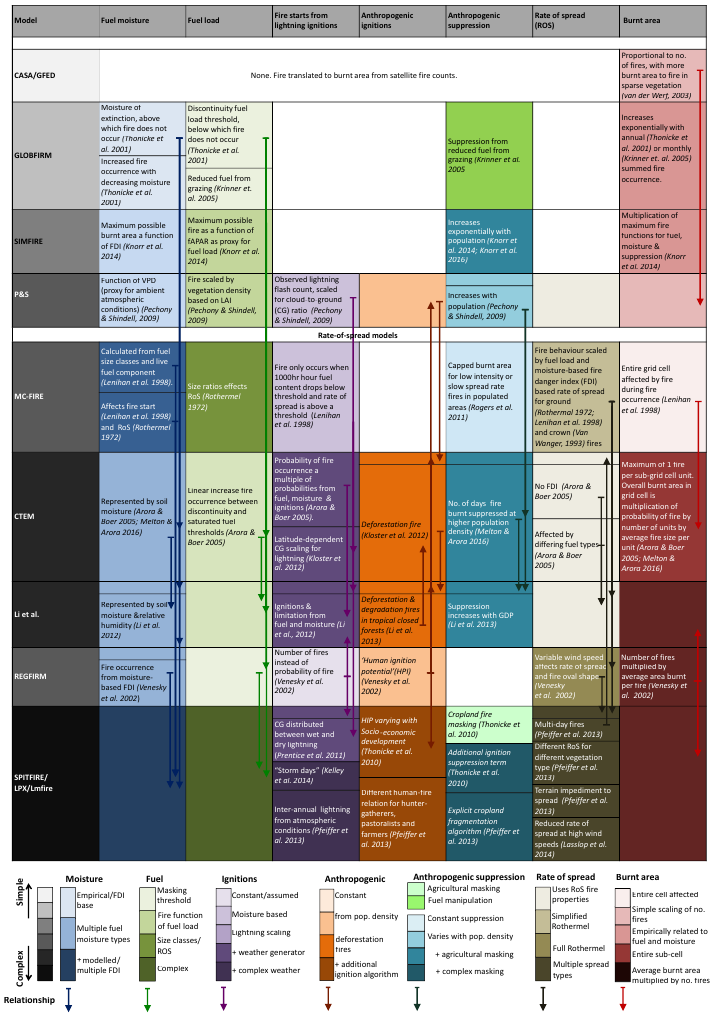
Table 1. Representation of fire processes in fire-enabled DGVMs. The intensity of the colour represents the complexity of the description of the process. Shades of grey describe the complexity of the model as a whole: light grey is the simplest and black the most complex. Blue represents the complexity of description of moisture control on fire susceptibility ranging from simple statistical relationships/fire danger indices (FDIs) of fuel as a whole (light blue) to description of moisture in multiple fuel size classes to fully modelled or specifically chosen FDIs for specific fuel moisture (dark blue). Green represents the complexity of fuel controlled fire susceptibility: simple masking at a specified fuel threshold (light green); fuel structure effects on ignition probability and rate of spread; and complex modelling of fuel bulk density (dark green). Purple shows complexity of natural ignition schemes: no specified/assumed ignitions (white); constant ignition source (light purple); simple relationship with fuel moisture; prescribed ignitions – normally through lightning climatology inputs; prescribed lightning with additional scaling for, for example, latitude-dependent cloud-to-ground lightning (CG); daily distributed lightning via a weather generator; and with additional complex ignition simulation (dark purple). Orange represents anthropogenic ignitions: none (white); constant background ignition source (light orange); ignitions varying based on human population density based on a “human ignition potential” (HIP) and/or gross domestic product (GDP); and inclusion of additional, complex human ignition schemes such as pre-historic human behaviour (dark orange). Cyan and lime green represent inclusion of human ignitions suppression and agriculture: none (white); constant suppression (light cyan); increasing suppression with population (medium cyan); simple agricultural masking of fire (light lime green); fuel load manipulation from agriculture (lime green); and a mix of agricultural and ignition suppression (dark cyan). Italic text under “human ignitions” and “human suppression” denotes models where the combined influence of human ignitions and suppression result in a unimodal description of fire relative to population density. Brown shows complexity of the calculation of fire sizes, typically through a rate-of-spread model (RoS): none (white); simplified RoS model to obtain fire properties (light brown); simplified RoS to model individual fires; full Rothermel RoS; and multiple RoS models (dark brown). Red shows complexity of the calculation of the overall burnt area: the entire cell is affected by fire (light red); constant scaling of the number of fires to burnt area depending on vegetation type; scaling based on moisture and fuel type; entirety of a sub-cell affected; and scaling of number of fires by fire size calculated by RoS model. Arrows demonstrate the exchange of components between models. Arrows start in the model containing the original process description.